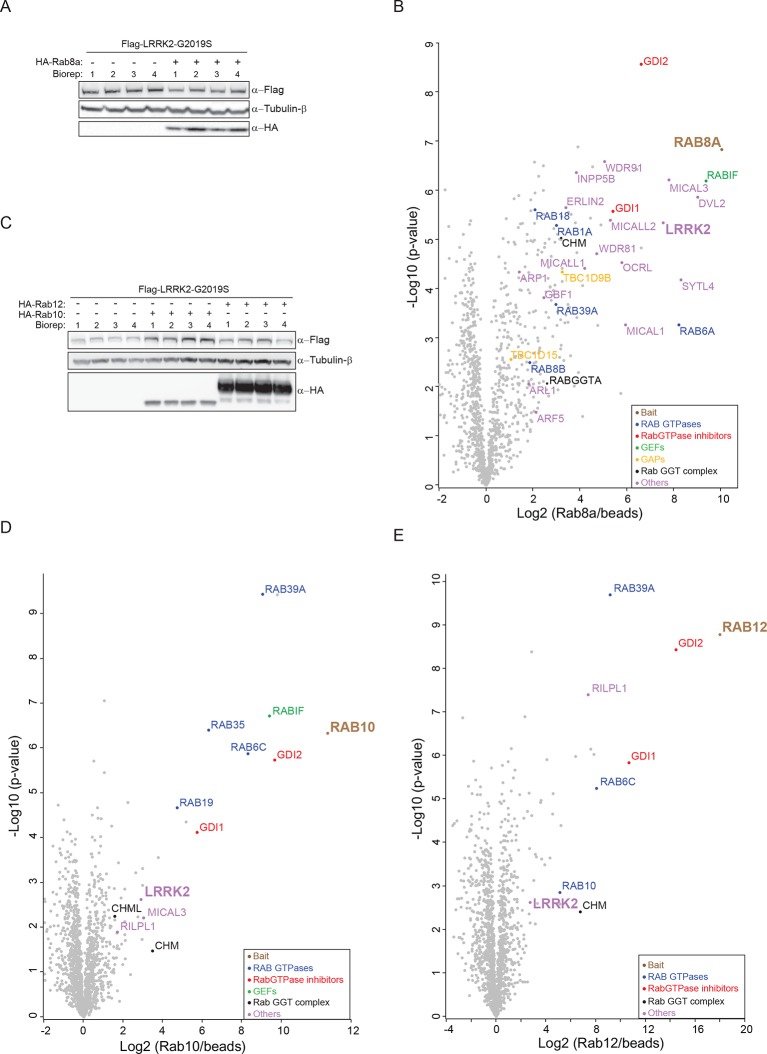
Several Rabs stably associate with LRRK2 in cells.(A) Western blot of HEK293 cells expressing flag-LRRK2-G2019S, either alone or in combination with HA-Rab8a. (B) Volcano plot of MS-quantified Rab8a interactors (n=4). (C) Same as (A) with HA-Rab10 or HA-Rab12. (D) and (E) Volcano plots of MS-quantified Rab10 and Rab12 interactors. MS, mass spectrometry.